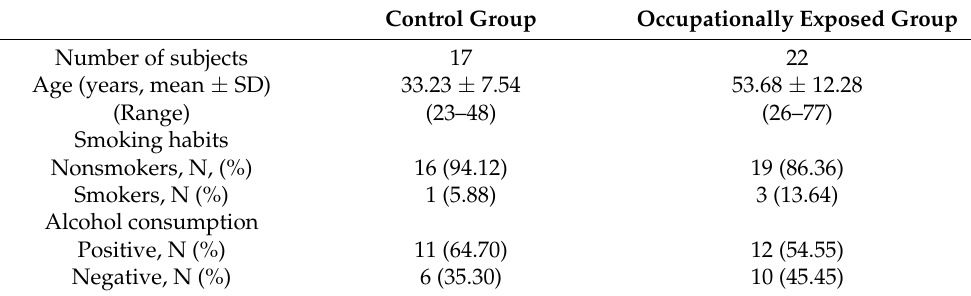
Table 1. Characteristics of the studied populations.